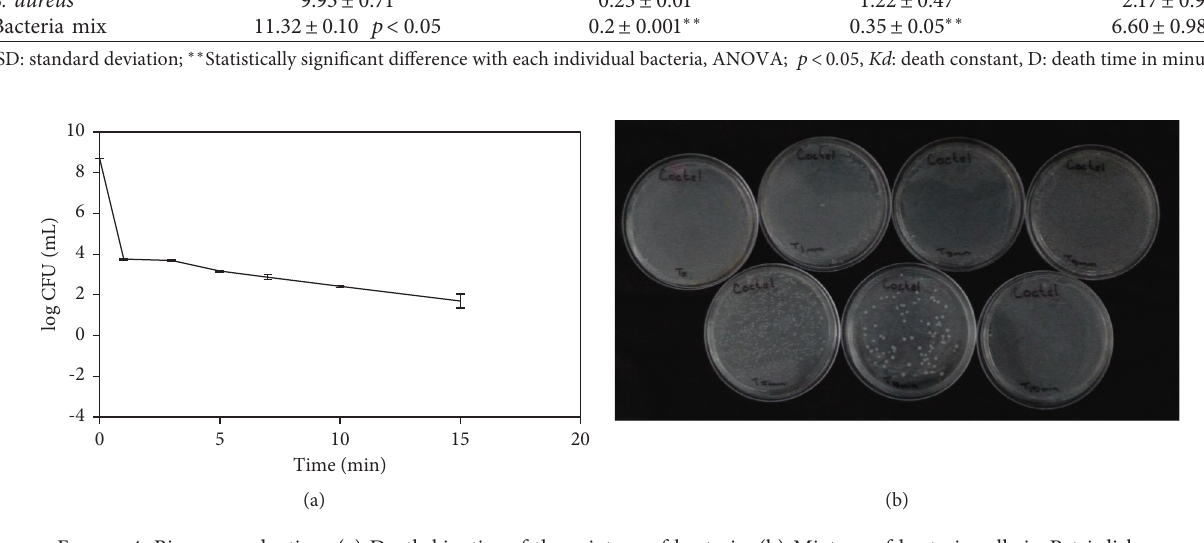
Figure 4: Biomass reduction. (a) Death kinetics of the mixture of bacteria; (b) Mixture of bacteria cells in Petri